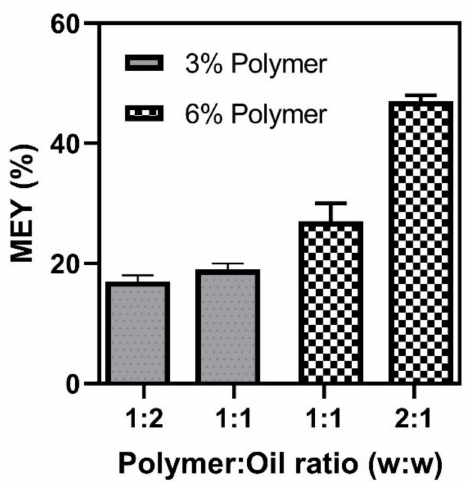
Figure 5. Microencapsulation yield of peppermint essential oil after spray drying for different Polymer:Oil ratios. Note that crosslinker concentration was kept constant at 5 wt% with respect to